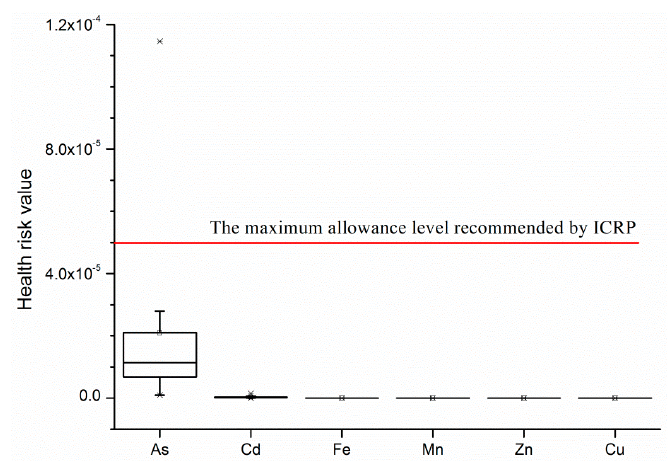
Figure 4. Health risk values of six trace elements in 57 sampling points.